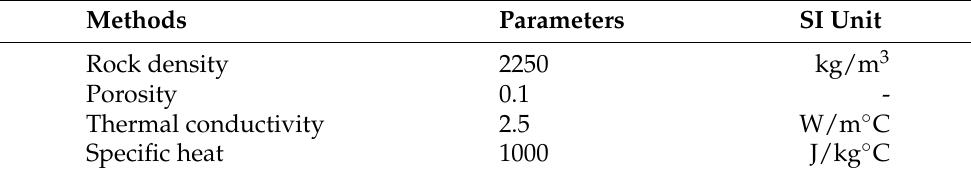
Figure 1. Simulation condition. ( a ) Simulation area with boundary conditions. ( b ) Examples of permeability distribution patterns in the reservoir area. The patterns were generated using a discrete cosine transformation. ( b ) (i–iii) depicts three different patterns. Table 1. Input parameters in